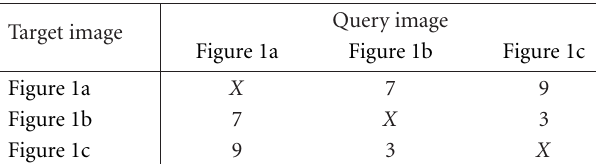
Table 1: Percentages of pixels with the same spatial coordinates whose rank measures within the green target and query images of Figure 1 are equal ( L = 256).